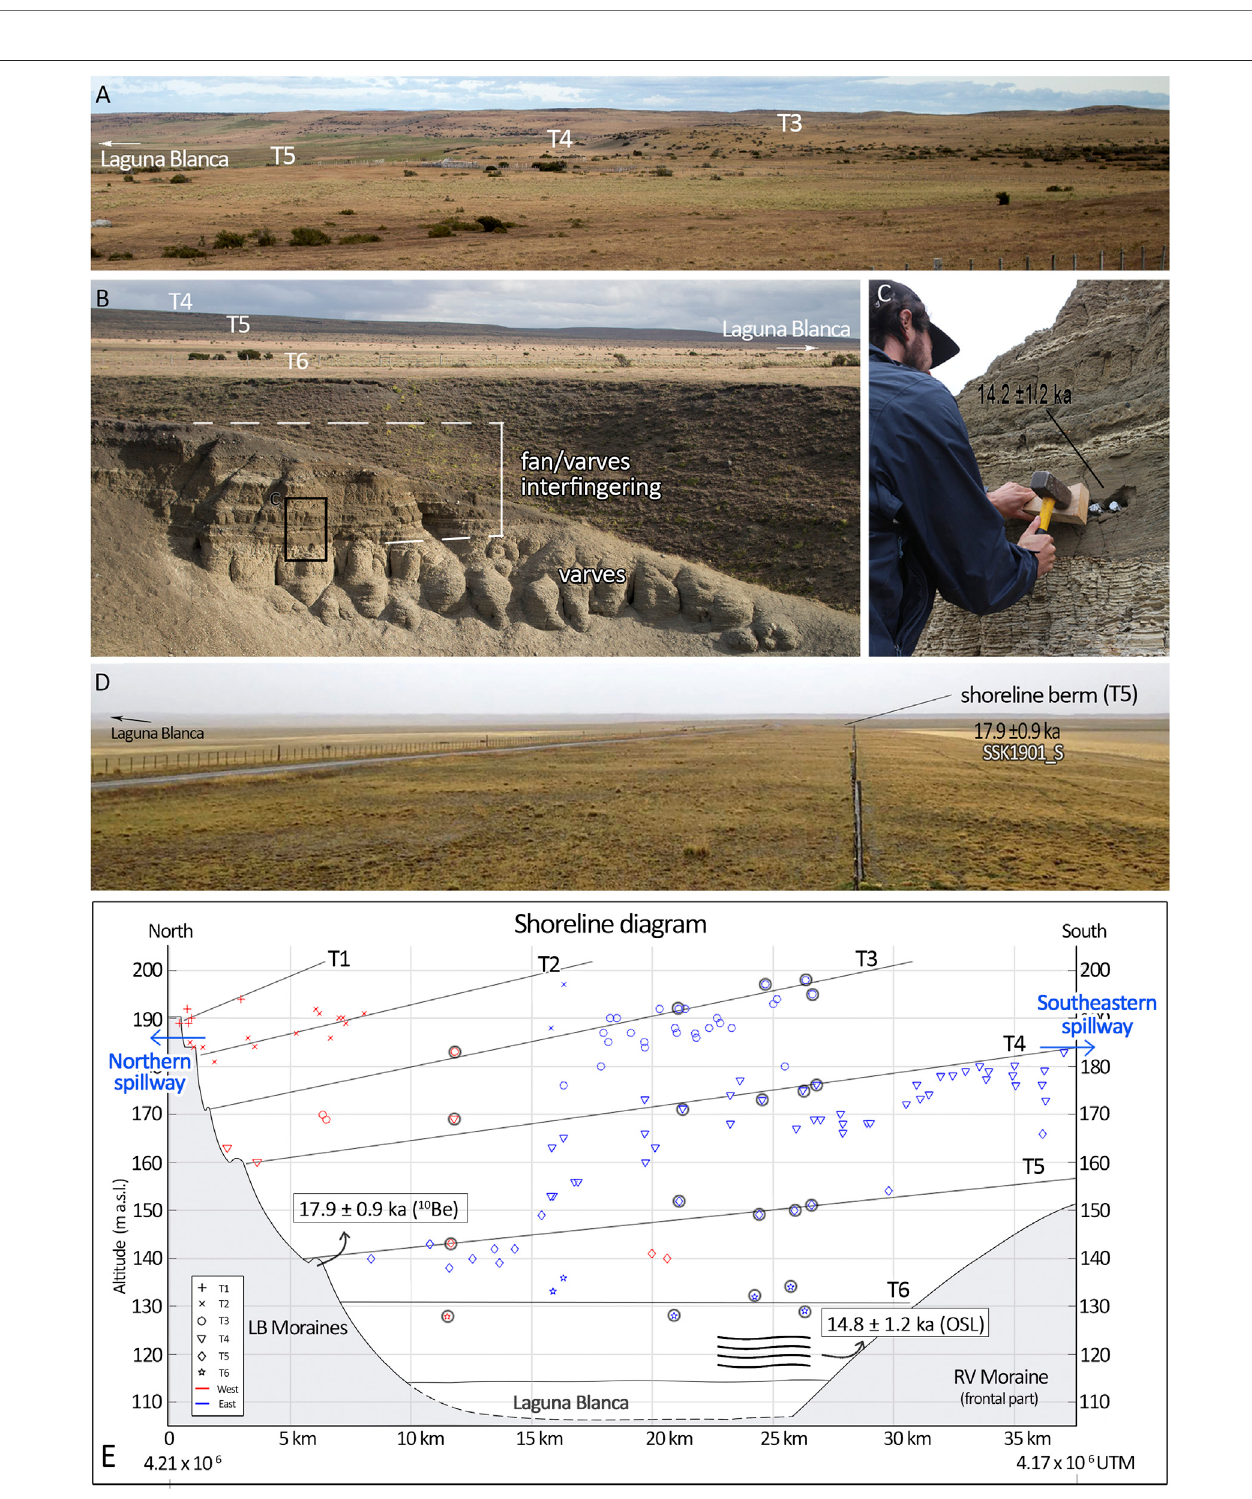
FIGURE 6 | Palaeo shorelines of Laguna Blanca. (A) Three terrace levels seen at the eastern side ofLaguna Blanca. (B) Incision of the lowest terrace, T6, exposes glaciolacustrine and alluvial fan sediments. (C) OSL sample from a sand layer of the lacustrine pro fi le (see panel b for location). (D) Palaeo shoreline berm located at the northpartofLagunaBlanca,thisbermisrelatedtoT5. (E) ShorelineDiagramoftheformerlevelsofLagunaBlanca.Thesymbolssurroundedbyablackcirclecorrespond tothemeasurementsdoneonthescarpbase.Thelocationsaremarkedofa 10 BeageoftheshorelinebermonT5,andanOSLsampleofasubaqueousalluvialfan taken from araised shoreline forming part of terrace T6. Data from west (red) and east (blue) are differentiated. The elevations and positions of the northern and south- eastern drainage spillways are marked. See legend for shoreline/terrace numbering.